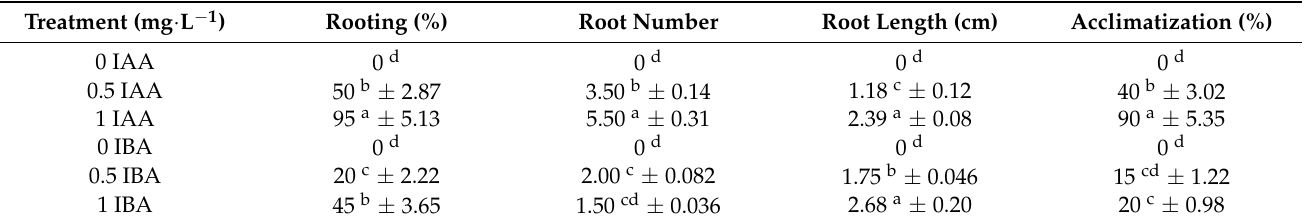
Table 2. Effect of various concentrations of IAA and IBA on the rooting and acclimatization of pear ( Pyrus communis L.) ‘Pyrodwarf ® (S)’ rootstock grown in